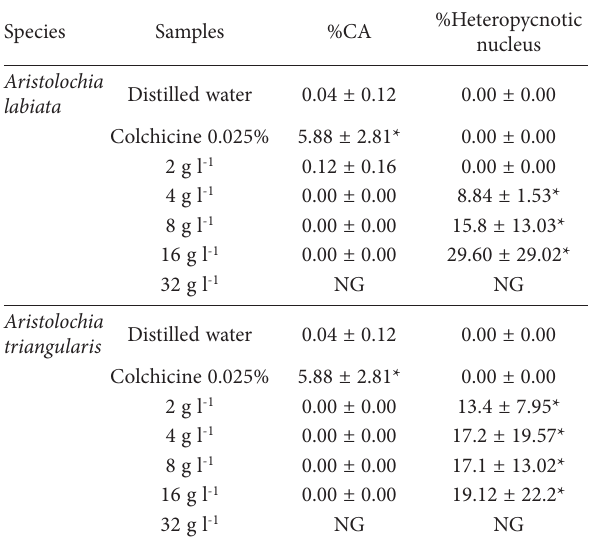
Table 5. Percentage of chromosomal alterations (CA) and heterop- ycnotic nucleus observed in Allium cepa cells exposed to decoction of Aristolochia labiata and Aristolochia